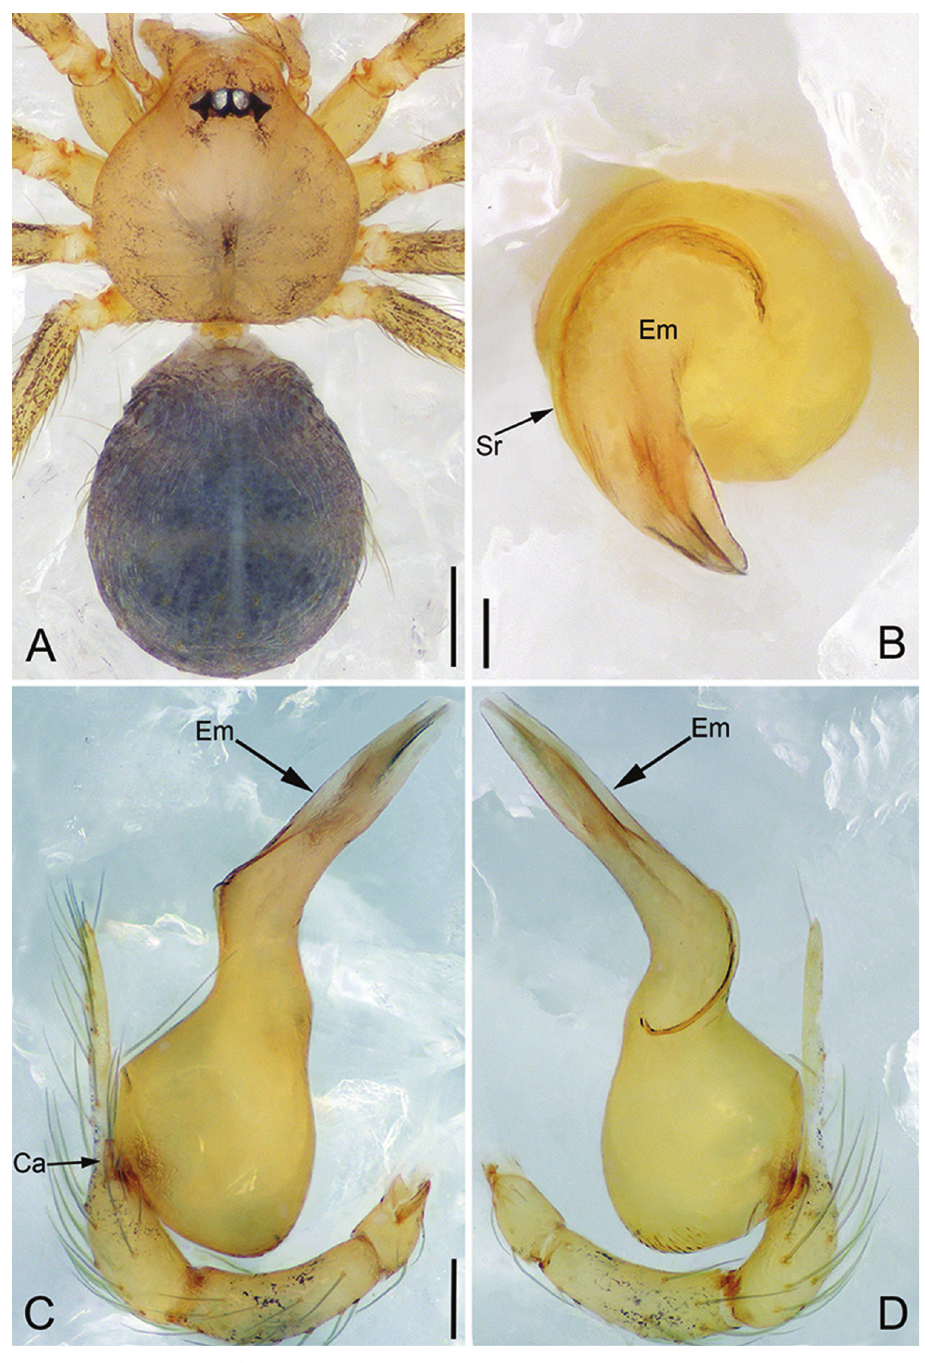
Figure 26. Pinelema yunchuni Zhao & Li, sp. n., male holotype. A Habitus, dorsal view B Embolus, apical view C Palp, prolateral view D Palp, retrolateral view. Scale bars: 0.2 mm ( A ), 0.05 mm ( B ), 0.1 mm ( C–D